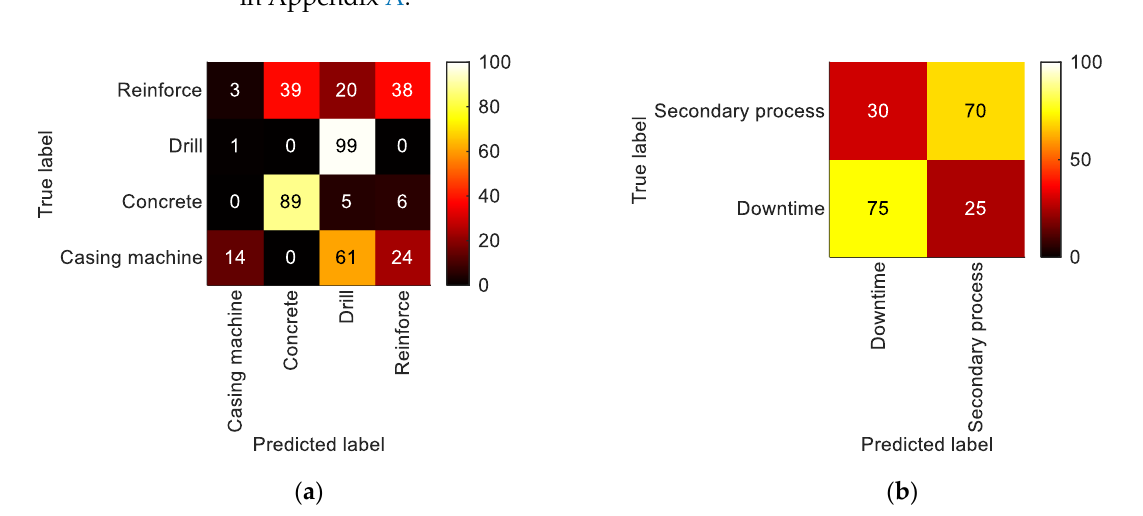
Figure 7. LoD2 confusion matrix for the DeepConvBiLSTM: ( a ) work; ( b ) idle.